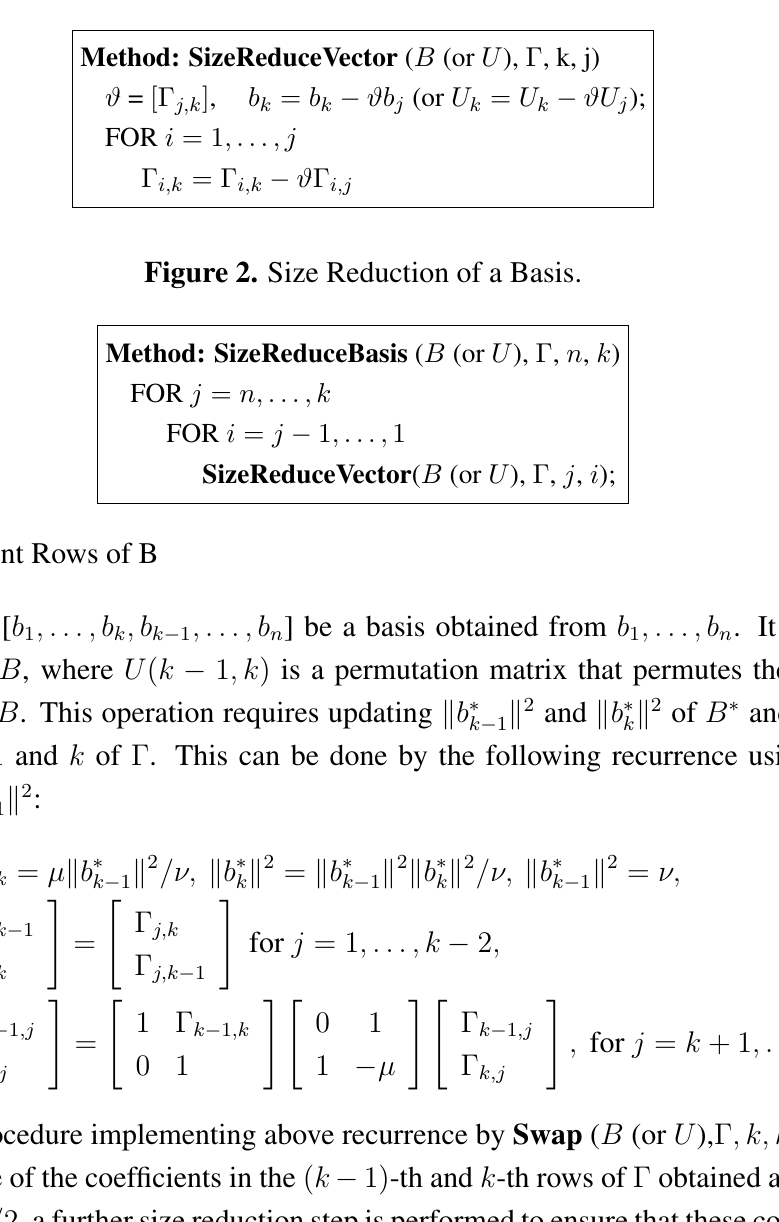
Figure 1. Size Reduction of a Basis Vector.